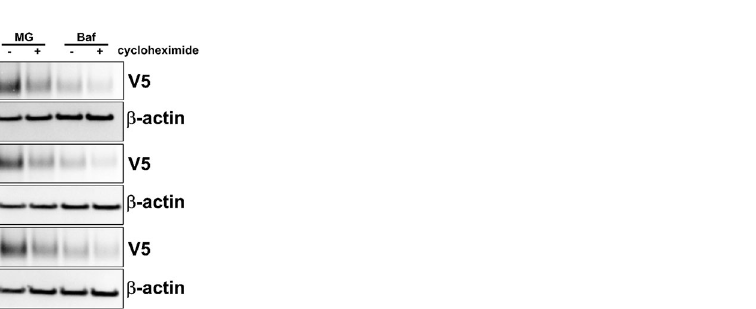
Figure 3. Degradation of ADGRG2-P622 is regulated by the residues in the CWI motif in the ECL2. HEK cells were transfected with the same dose of plasmids (1 µg) expressing P622-CWI or mutants. Cells were then incubated with cycloheximide (100 µg/ml) for up to 8 h and total cell lysates were run on SDS-PAGE, transferred to PVDF membranes, and probed with V5 and β-actin antibodies. Differential exposure time in the iBright Imaging system was used to make the mutants visible to facilitate the band density quantification. Representative blots show a reduction of mutant receptor levels over time. Density values of V5 were normalized to that of β-actin for each plasmid at NT (0 h). Densitometry analyses are shown on the right. Data are mean ± S.E.M from 4 independent experiments. Uncropped blots are provided in Supplementary Fig. 5. Two- Way ANOVA with Dunnett’s multiple test was used to compare protein levels at each time point to that of basal expression (NT) of respective receptors. *P < 0.05; **P < 0.01; ***P < 0.001; ****P < 0.0001.